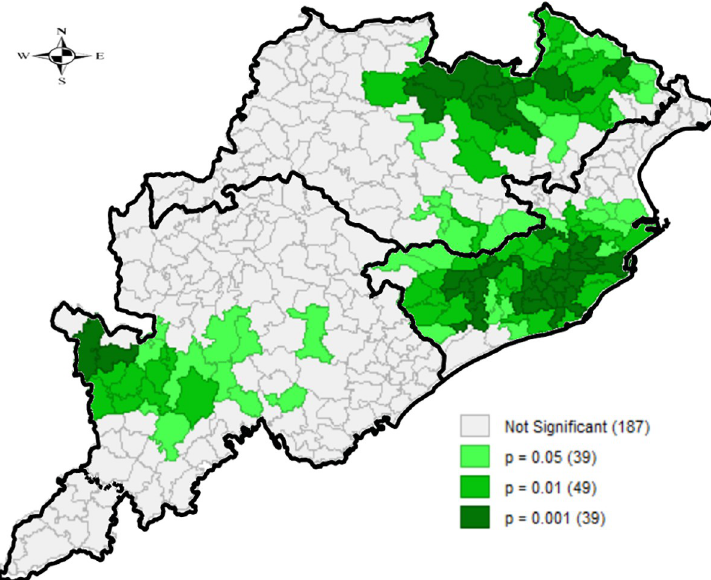
Fig 3. Univariate LISA significance map for children underweight, block-wise, CCM-II, 2014–15, Odisha, India.